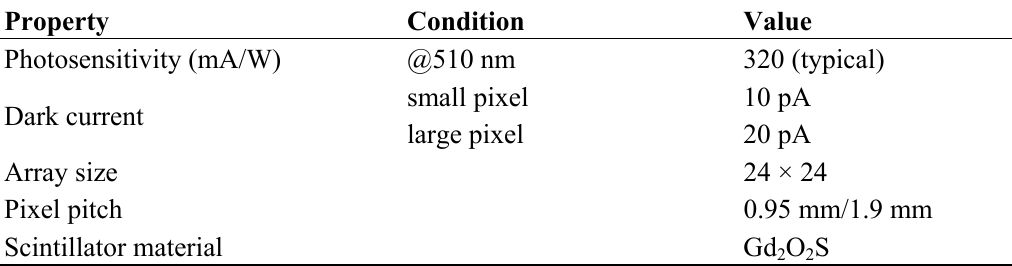
Table 1. Properties of photodiode array assembly.